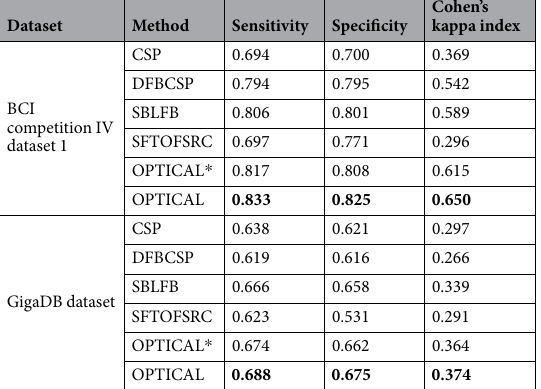
Table 3. A comparison of the statistical measures of the proposed predictor with other competing methods.